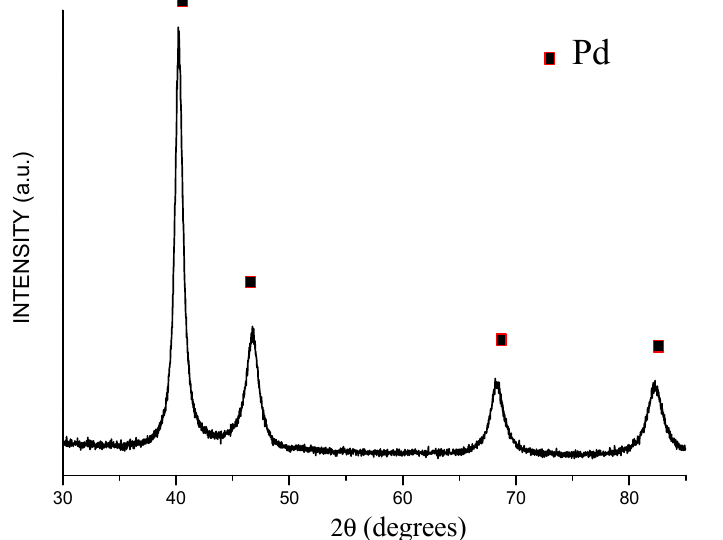
Figure 7. XRD pattern of the product of acid treatment of Fe@Pd core–shell particles (hollow particles of a Pd-based alloy).